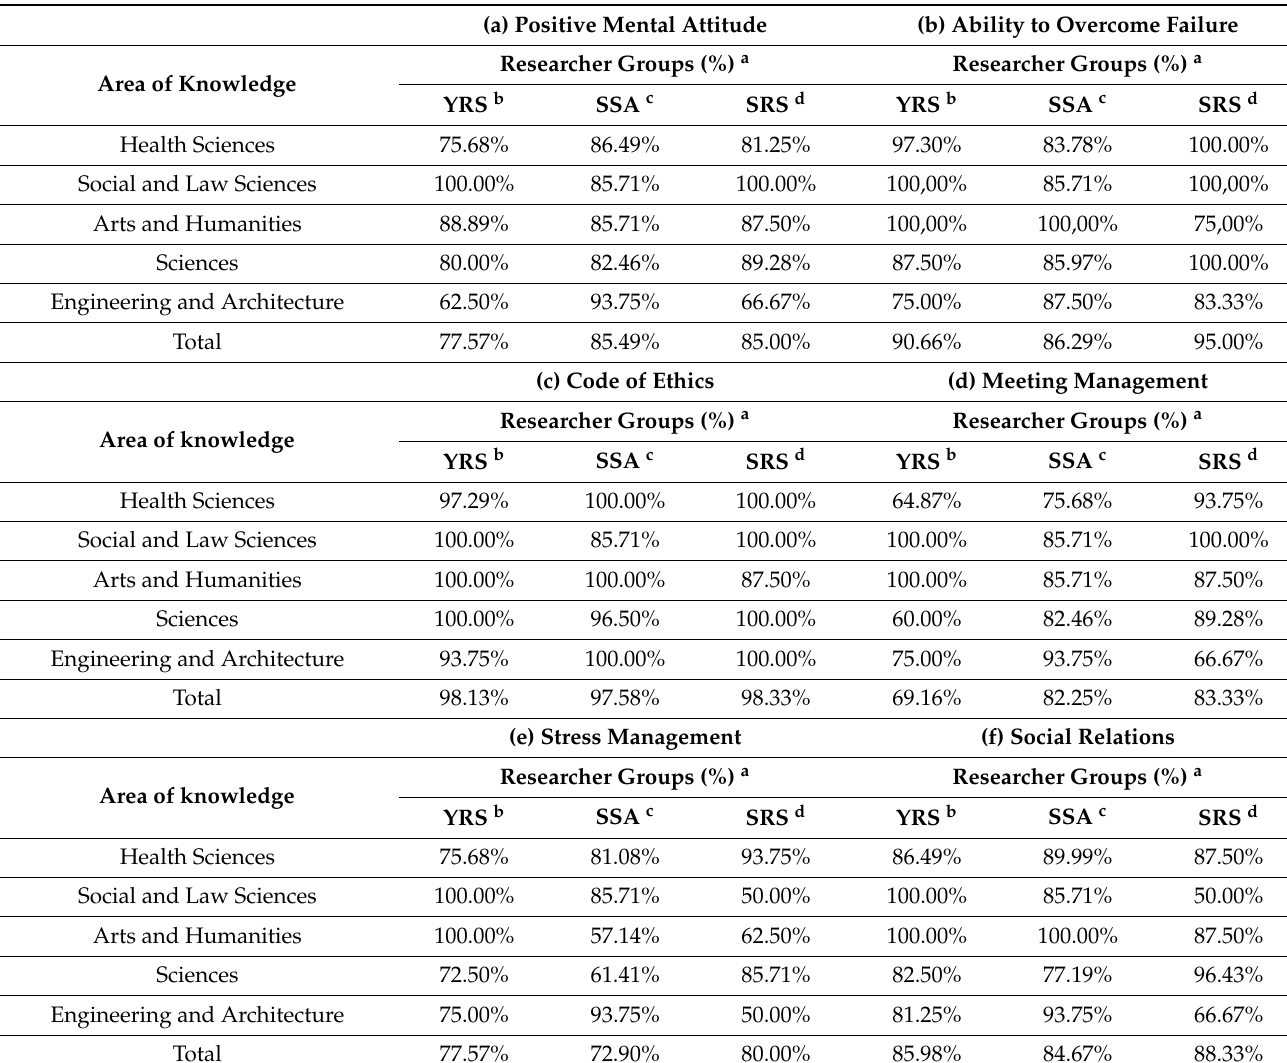
Table 3. The magnitude of the acquisition of entrepreneurial skills by area of knowledge and research